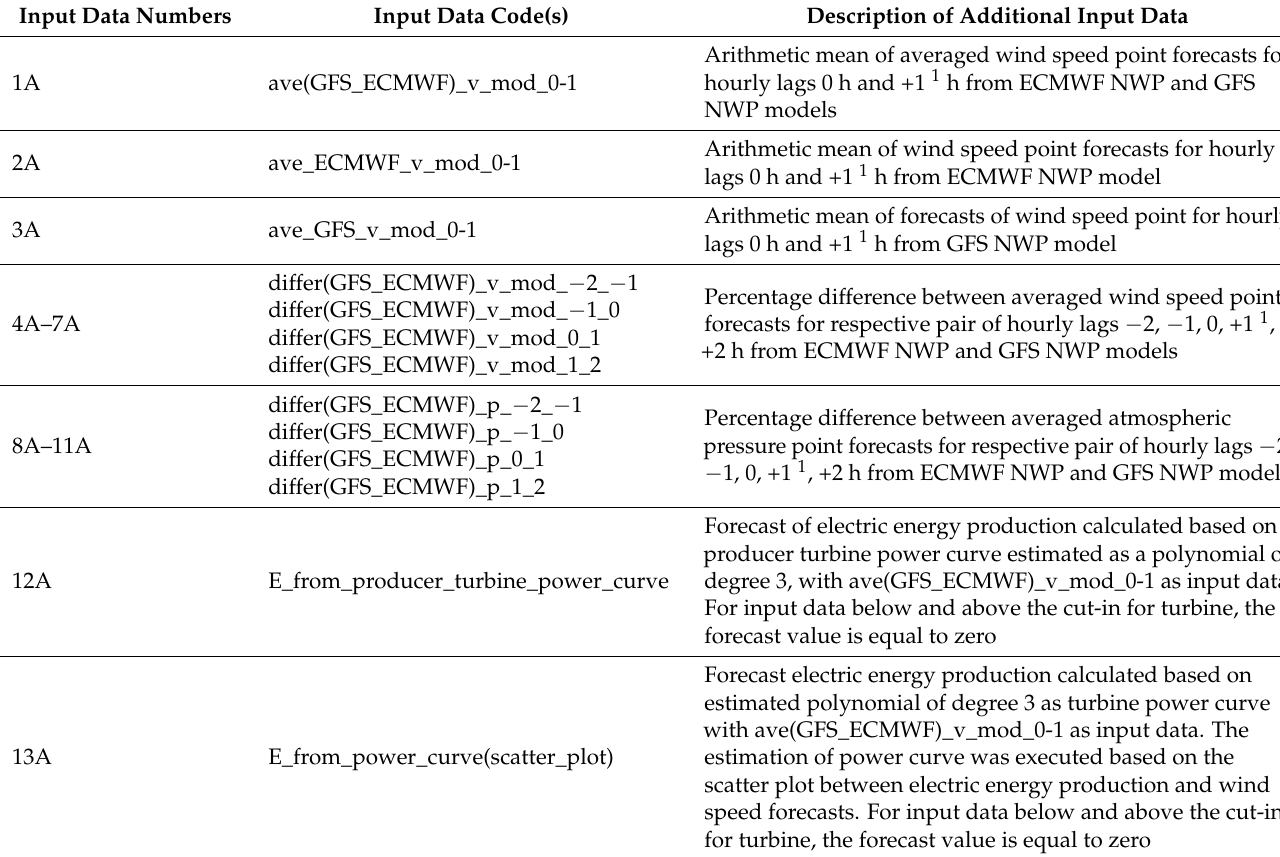
Figure 11. Interrelationship matrix (Pearson linear correlation coefficients) between 4 methods used to determine the importance of input variables. Table 3. Description of additional input variables created for forecasting